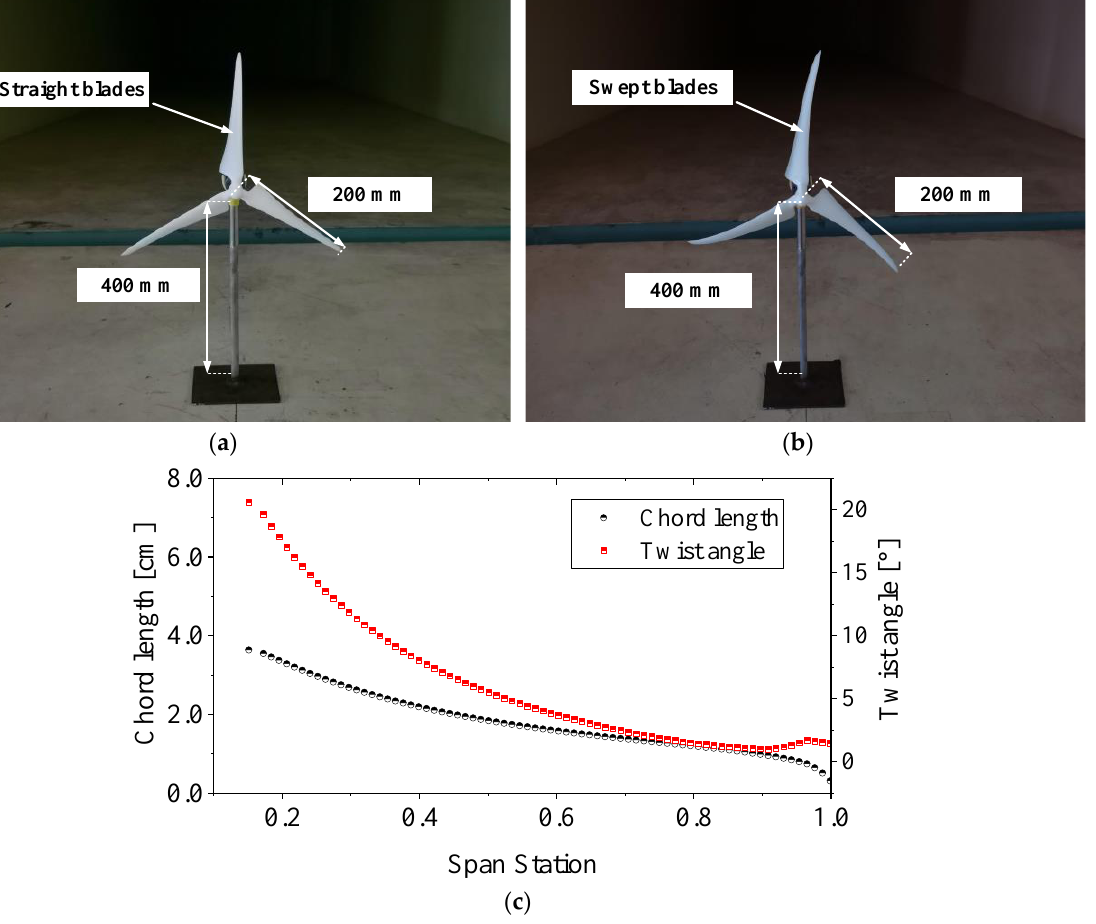
Figure 7. Photographs of the wind turbines with different blades taken inside the wind tunnel. ( a ) Straight blade; ( b ) swept blade; ( c ) blade parameters.